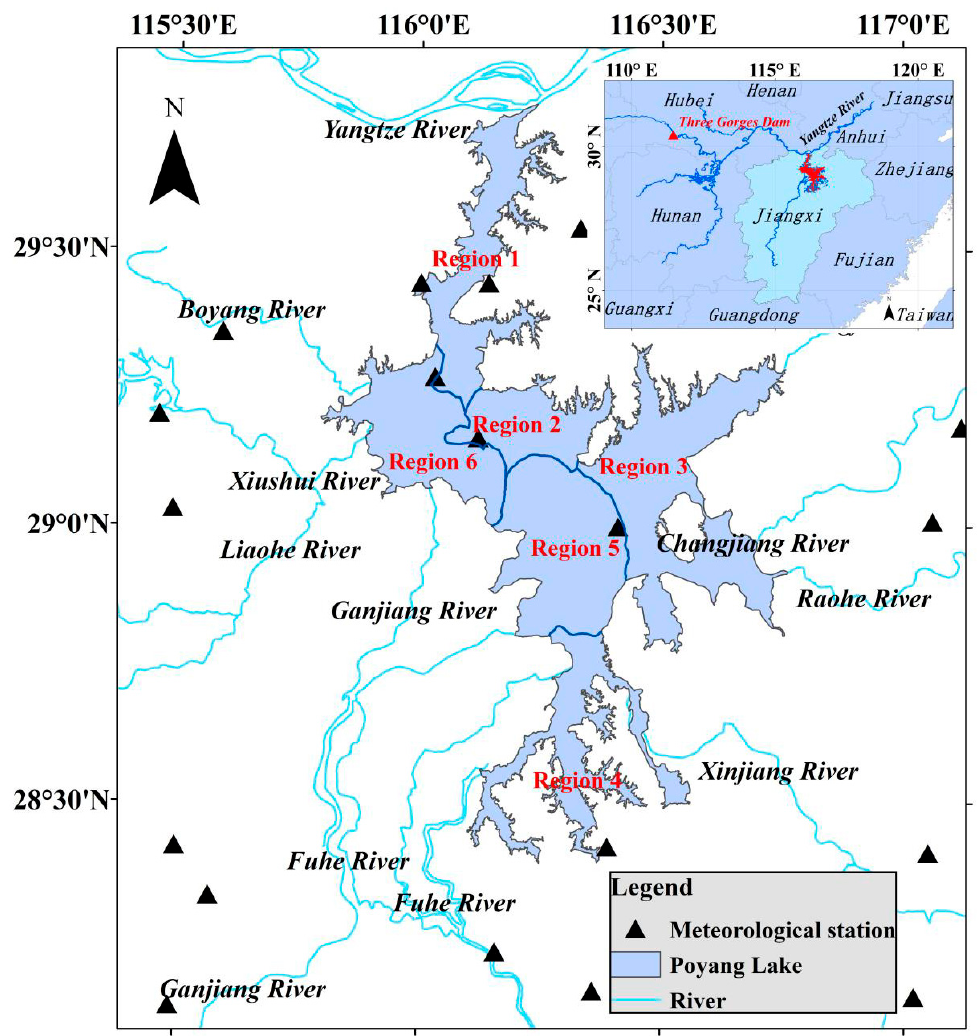
Figure 1. Location of Poyang Lake and its hydrographical regions. The bold blue lines are the boundaries of the six hydrographical regions. The inset shows the locations of the Yangtze, the TGD (the red triangle), and Poyang Lake. The black triangles are the locations of 19 hydrological stations.